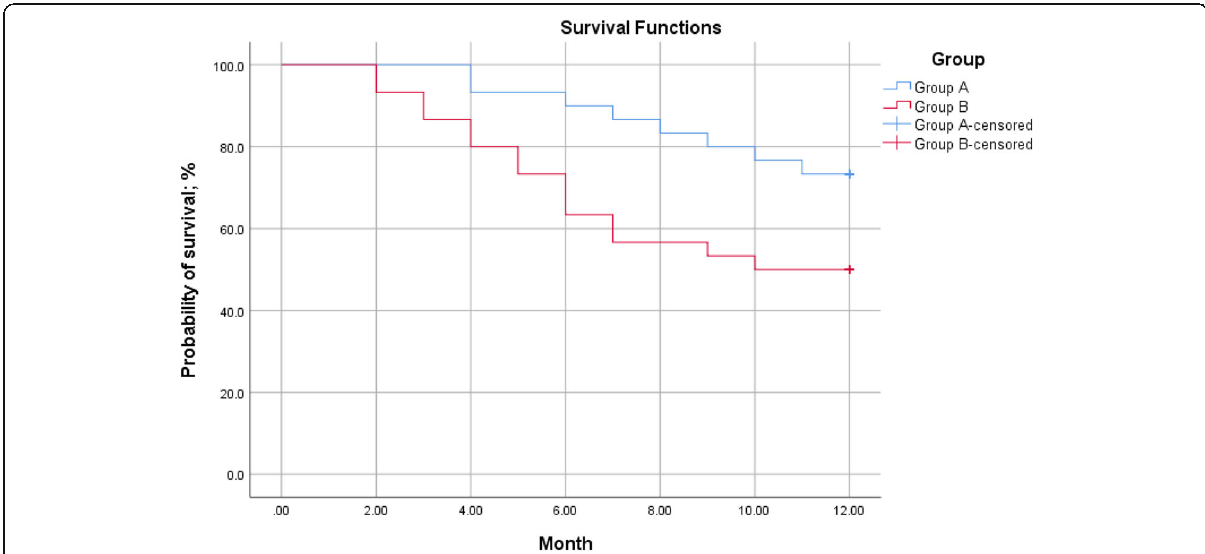
Fig. 1 Comparison of the median survival by the Kaplan-Meier method; for group A patients [endobronchial cryotherapy (EBCT) + chemoradiotherapy (CRT)] and group B patients [chemoradiotherapy (CRT)]. The median survival; 9.7±0.4 months (95% CI= 8.86 – 10.54), T test = 2.631, P =